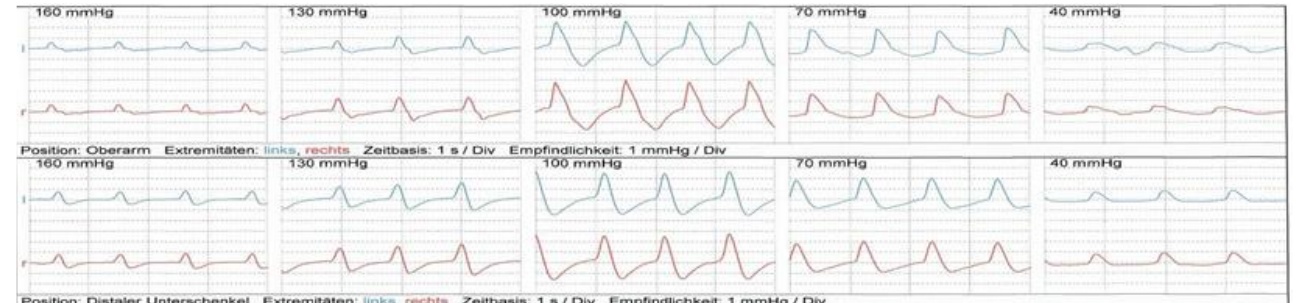
Figure 2. Pneumatic segmental pulse oscillography (P-SPO) of upper and lower extremities at rest. Pneumatic segmental pulsoscillography (P-SPO) of upper and lower extremities at rest showed regular findings. Upper half: upper arm, blue = left arm; red = right arm. Lower half: distal lower leg, blue = left leg; red = right leg; l = left; r = right.